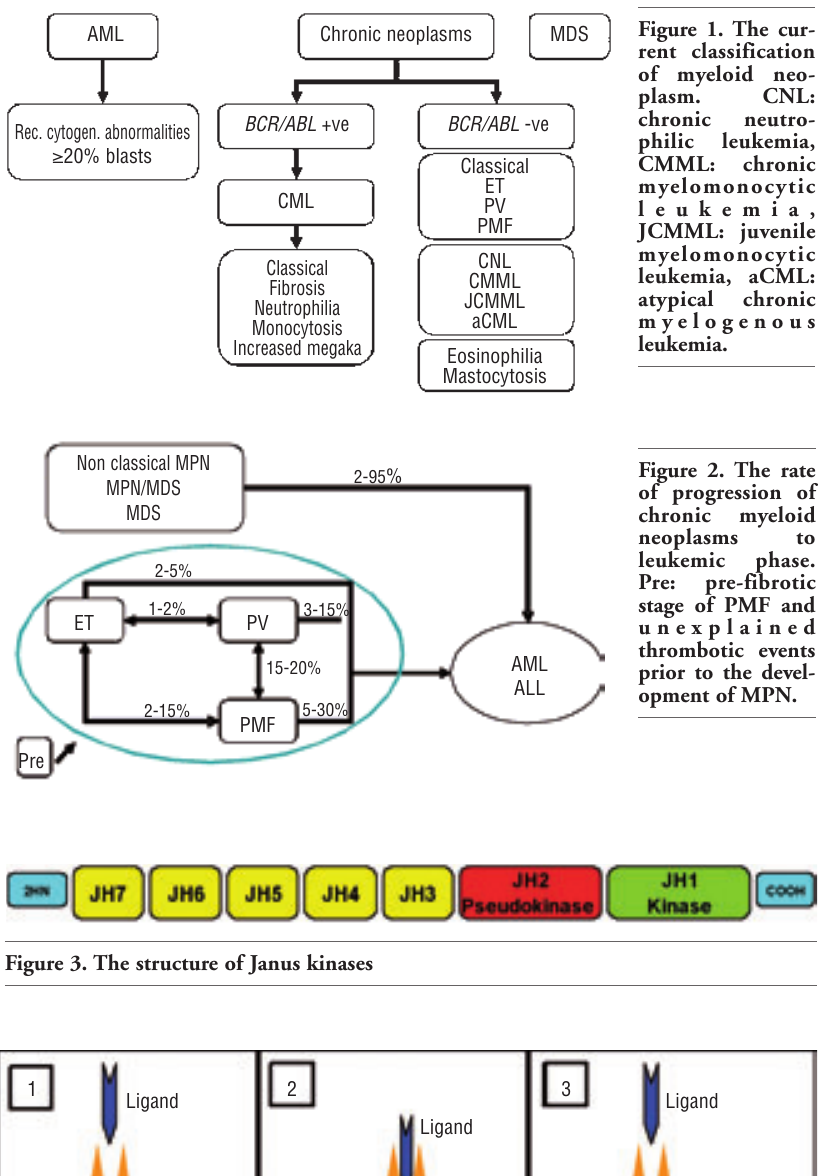
Figure 1. The cur- rent classification of myeloid neo- plasm.